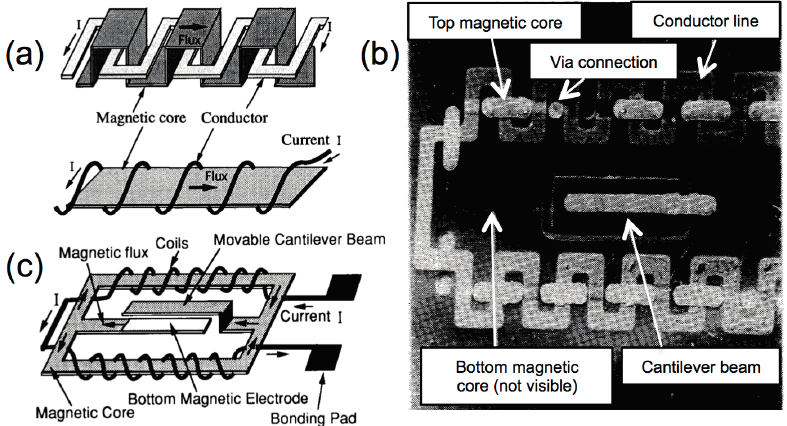
Figure 7. Concept and fabrication of a fully integrated magnetic microactuator [129]. ( a ) Concept of meander core and corresponding model; ( b ) Micrograph of the fabricated microactuator; and ( c ) Scheme of the microactuator. Reprinted with permission from [129]. Copyright 1993 IEEE.